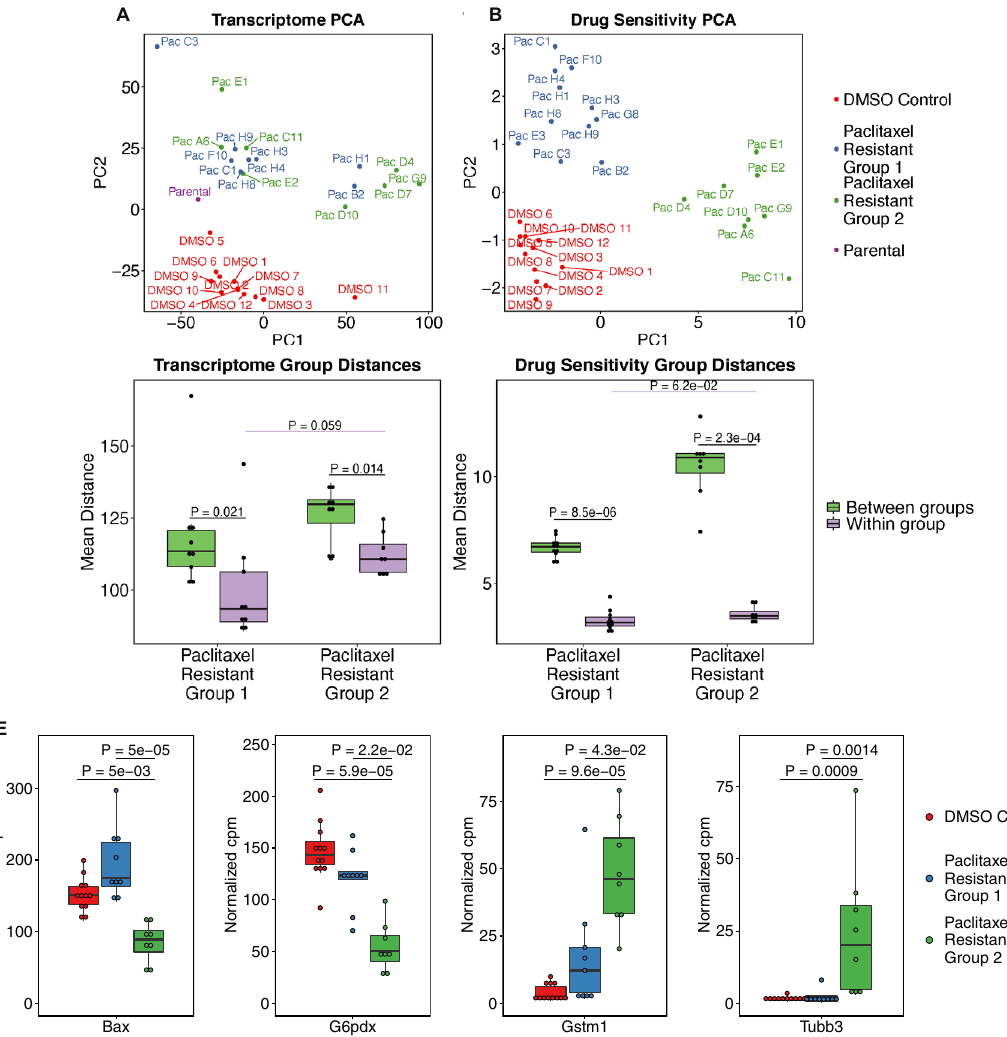
Figure 5. Phenotype-based groups of paclitaxel resistant cell lines. (A) log of TMM-normalized counts-per- million expression values from RNA-seq and (B) PCA plots of log 2 EC 50 fold change values for the paclitaxel resistant cell lines, DMSO control lines, and parental line. The blue and green annotated phenotypic groups are independent of the apparent transcriptome groups (Fisher’s Exact Test P = 0.33). Mean Euclidian distance separating cell lines between and within the phenotype-based paclitaxel resistance groups in (C) transcriptome space, and in (D) drug resistance space. FDR-corrected P-values are reported for two-sample Wilcoxon tests. (E) TMM-normalized counts for genes with a significant Kruskal–Wallis test and significant post-hoc Dunn’s test (Supplementary Fig. S2) are shown. FDR-corrected P-values are shown for post-hoc Dunn’s test of the indicated